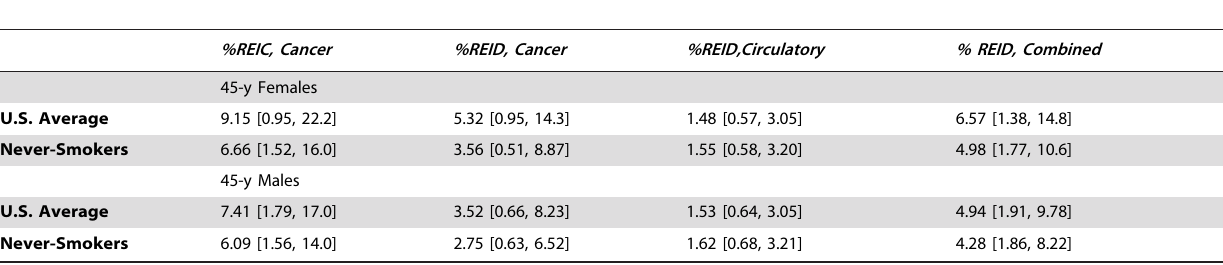
Table 1. Lifetime risks for the 940 d, Mars Design reference mission for cancer and circulatory disease for average solar